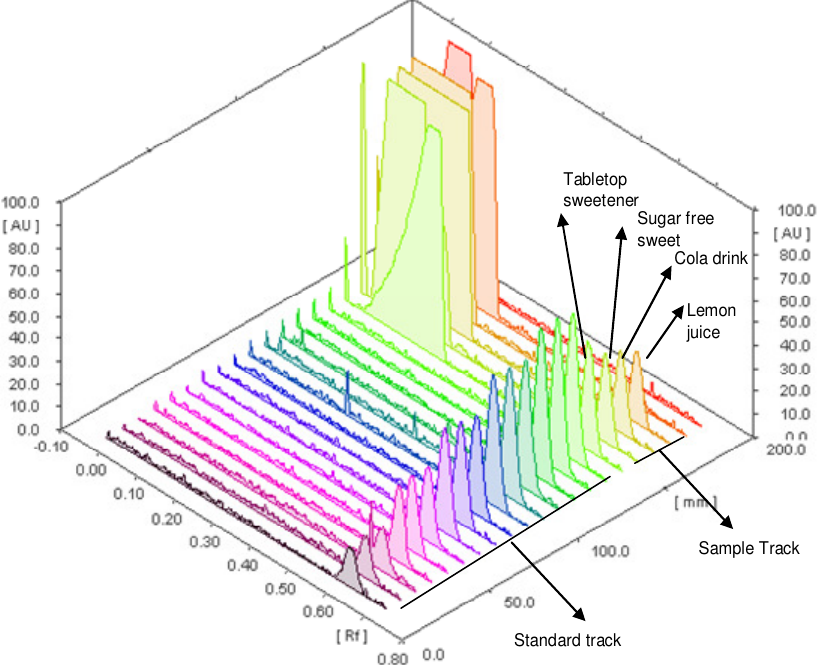
Figure 2. Absorbance measurement of sucralose at 456 nm after derivatization with the rhodamine-sulfuric acid reagent; tracks 1-15 sucralose standards tracks 16, 17, 18, 19 are of Cola drink, Lemon juice, Sugar free sweet and Tabletop sweetener respectively (Solvent